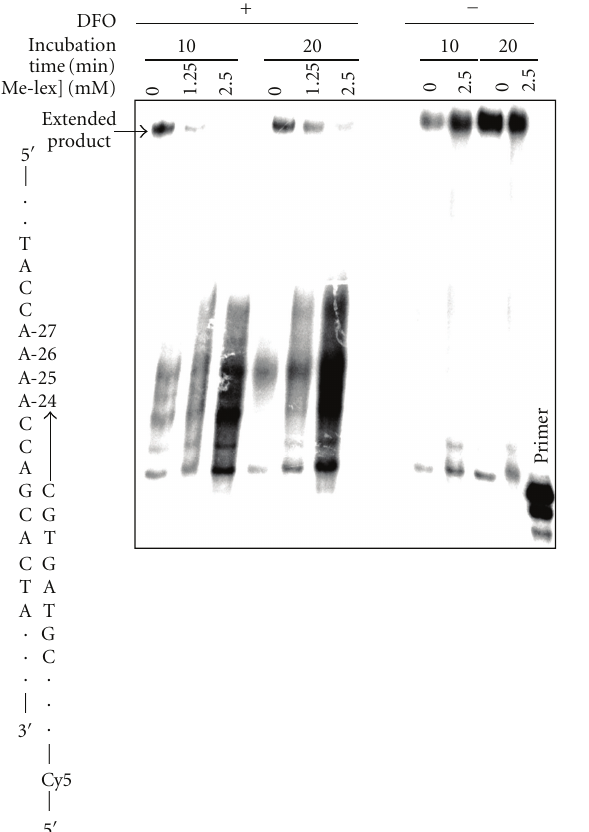
Figure 3: The e ff ect of 3-mA on DNA polymerization by Pol η . The DNA template (100nM) was treated with 0, 1.25 or 2.5 mM Me-lex for 12 hours at 4 ◦ C in the presence (+) or absence ( − ) of the DFO: 3-mA forms at A-26 and A-27 only when DFO is present (Figure 1). The runup polymerization was initiated by raising incubation temperature to 37 ◦ C and the addition of 5 (cid:2) - Cy5-primer (200nM) and dNTPs (0 or 100 μ M). Polymerization experiments were run for 10 or 20 minutes. The polymerase is blocked at the methylated adenines, which is also reflected in the level of extended product. Extension is e ffi cient if the DFO is not present during the methylation step (Scheme 1).